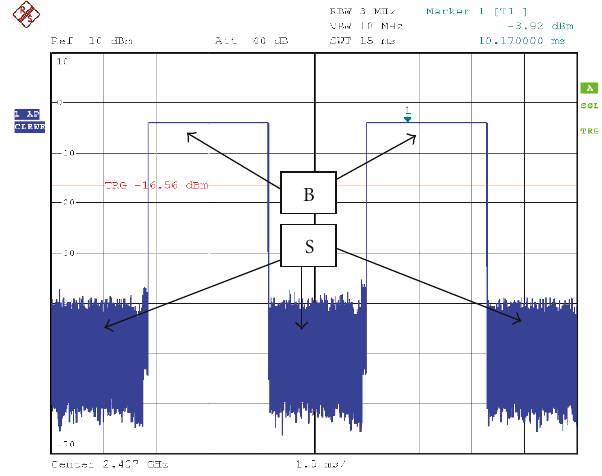
Figure 10: Only one source node is switched on. Note: that S represents the synchronization time slot during which sources are in receive mode and B represents the beamforming time slot.